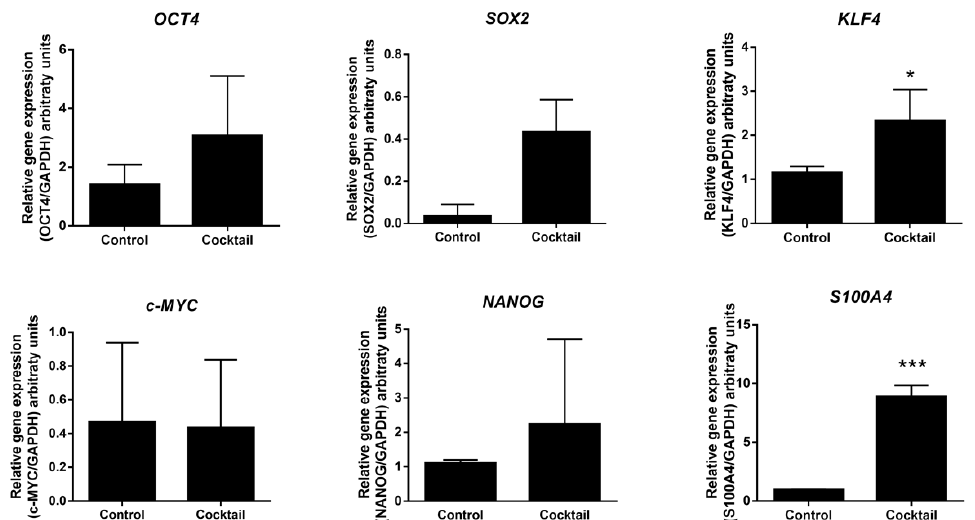
Figure 3. Expression of pluripotency genes after treatment of human fibroblasts with the epigenetic cocktail in the absence of the reprogramming genes. Cells were cultured for 15 days in stage 1 medium followed by 15 days in stage 2 medium, as described in Materials and Methods. Each bar represents the mean ± SD of three independent experiments, except for SOX2 gene, which was performed in duplicate. Results were normalized to GAPDH gene expression. Cocktail contains 1 mM VPA, 1 µ M 5AZ, 5 µ M CHIR99021, and 0.5 µ M A83-01. * p < 0.05; *** p < 0.001.